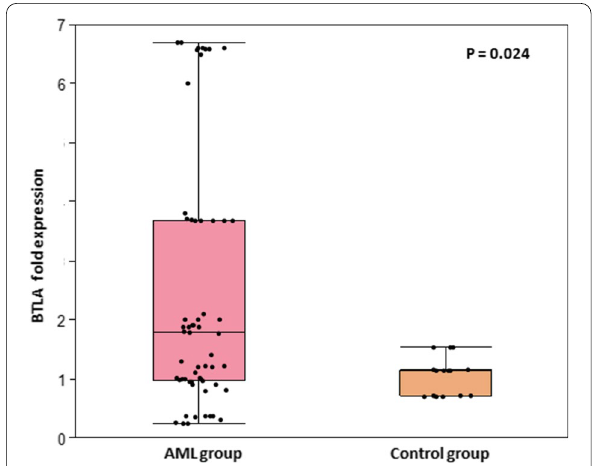
Fig. 1 BTLA fold expression in cases of AML and control group. Box represents the interquartile range. Line inside the box represents the median. Whiskers represent minimum and maximum values. Dots represent individual